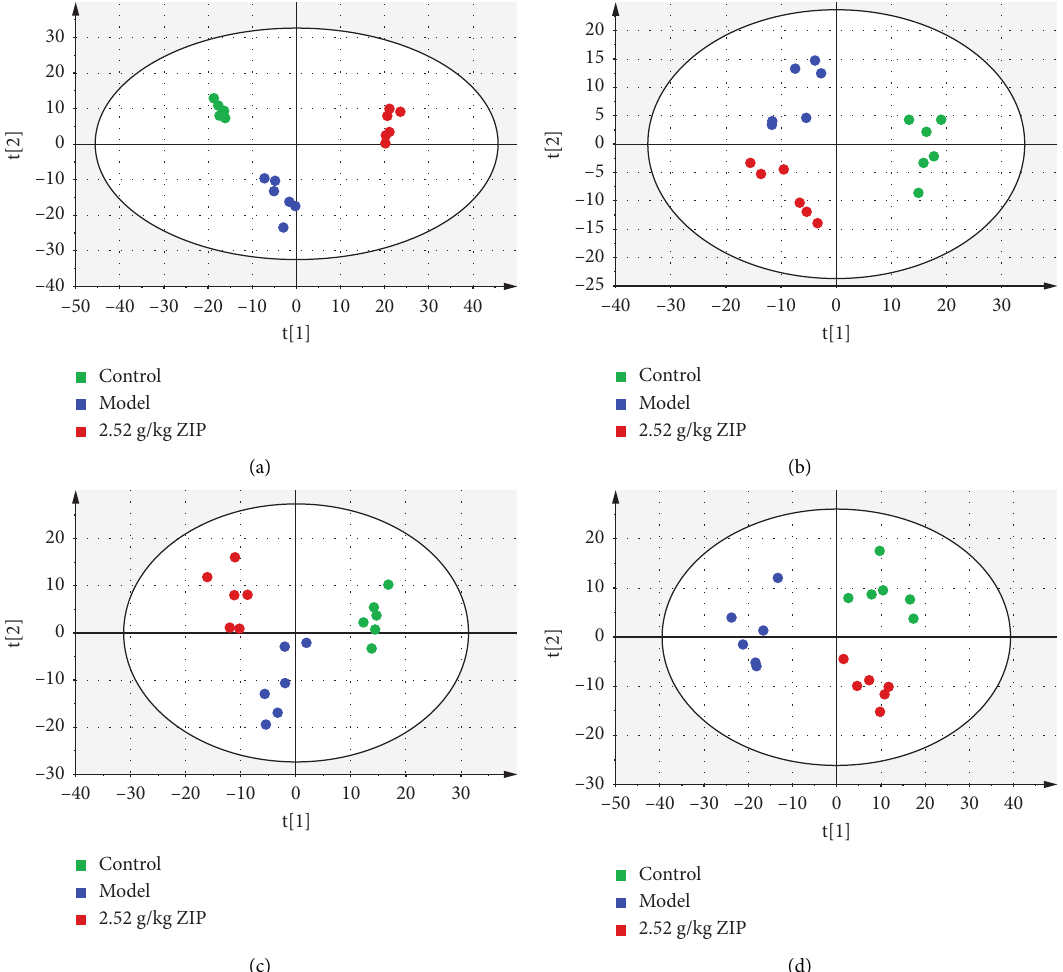
Figure 3: PCA score plot of the control group, the model group, and 2.52g/kg ZJP group. (a) ESI+ mode of PCA in serum samples between the three groups. (b) ESI − mode of PCA in serum samples between the three groups. (c) ESI+ mode of PCA in urine samples between the three groups. (d) ESI − mode of PCA in urine samples between the three